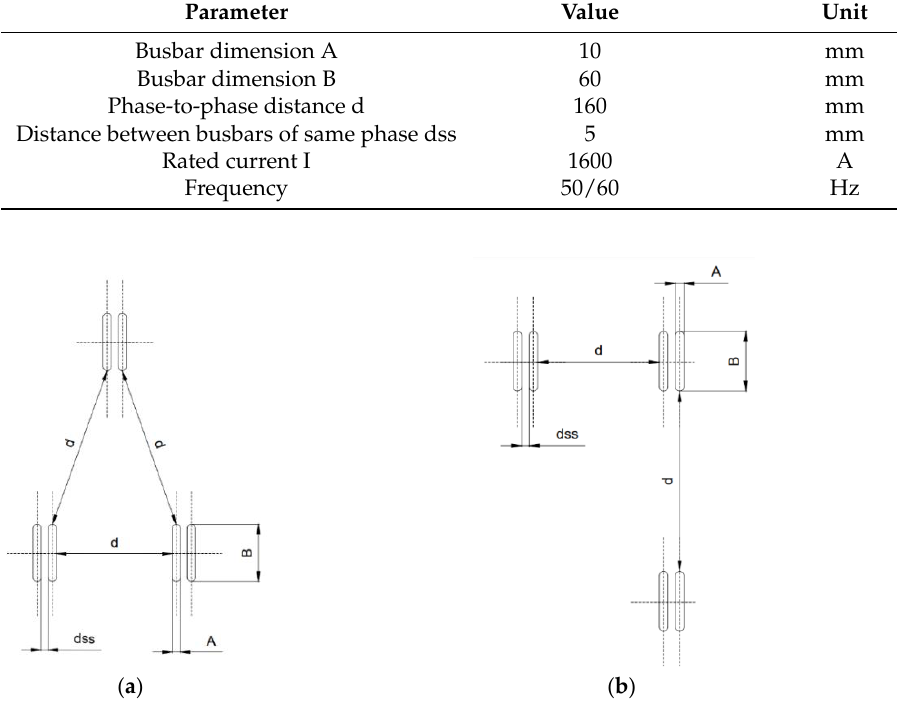
Figure 5. Layout of: ( a ) Model 3; ( b ) Model 4.